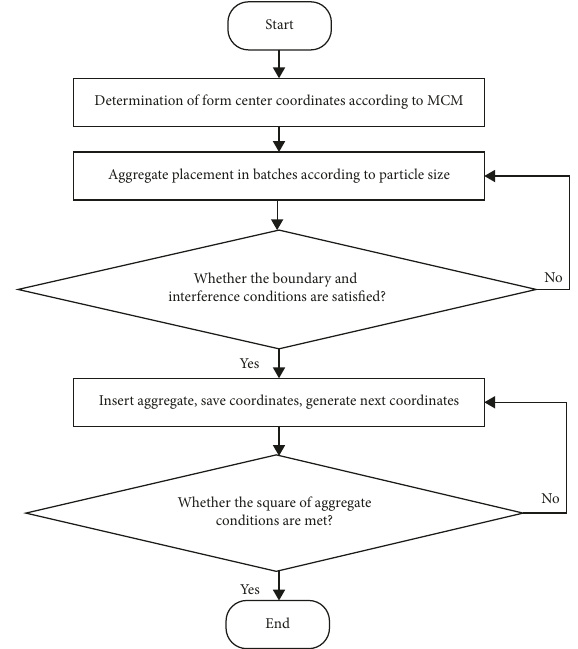
Figure 3: Flowchart of aggregate generation.